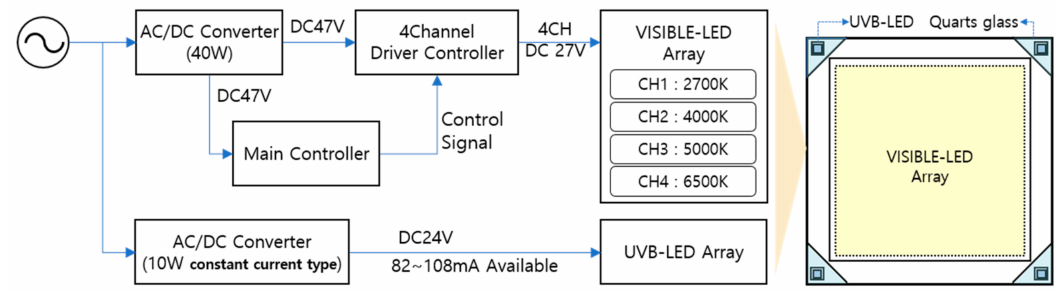
Figure 1. UVB-LED general lighting